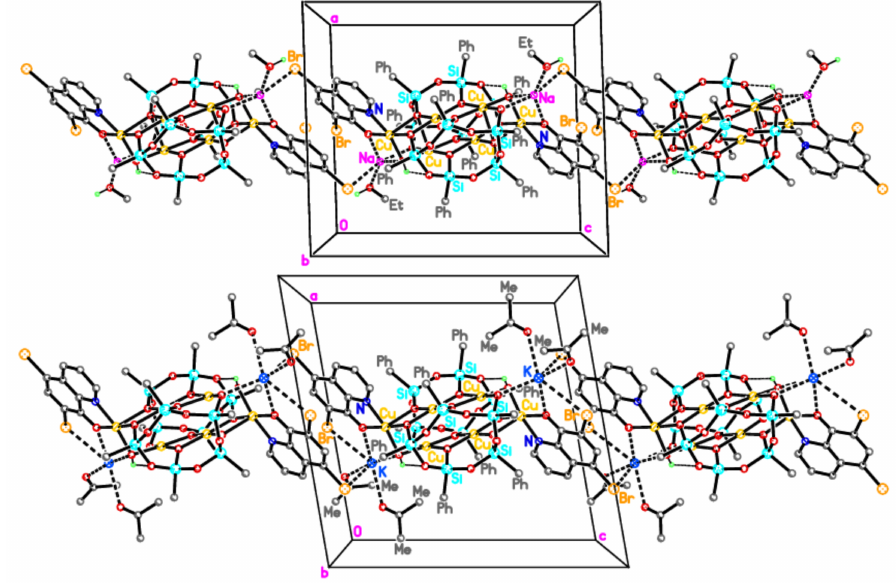
Figure 7. Top . A fragment of the 1D coordination polymer structure of 7 . Bottom . A fragment of the 1D coordination polymer structure of 8